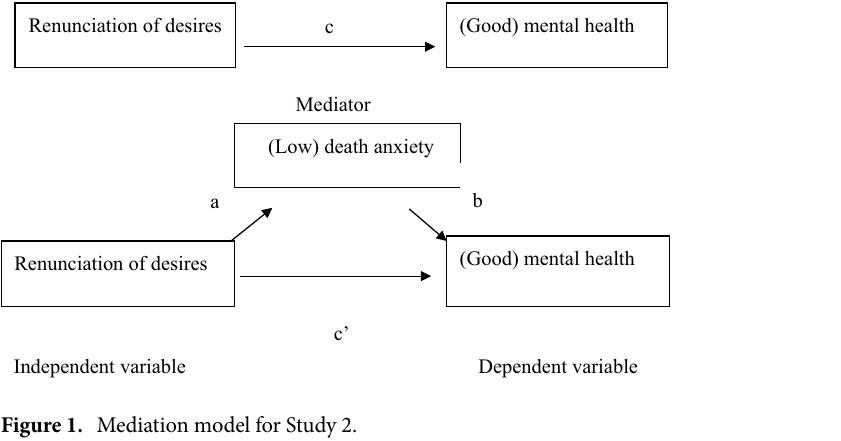
Figure 1. Mediation model for Study